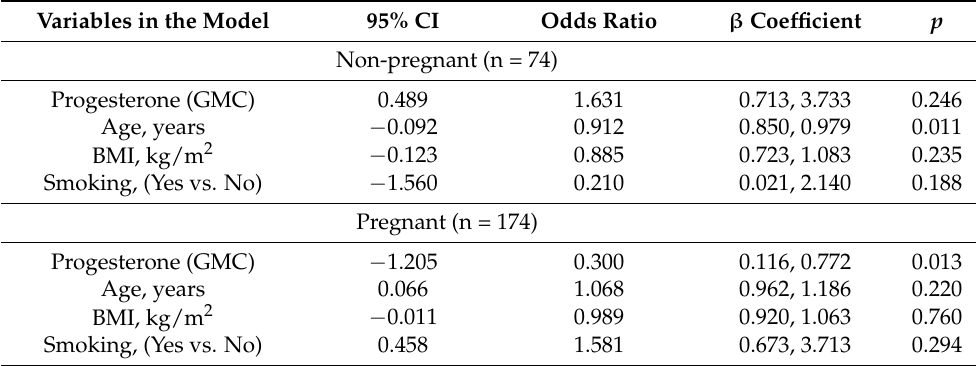
Table 4. Multiple logistic regression analysis for the association between anti-PT IgG antibody levels with progesterone, age, BMI, smoking status in non-pregnant and pregnant